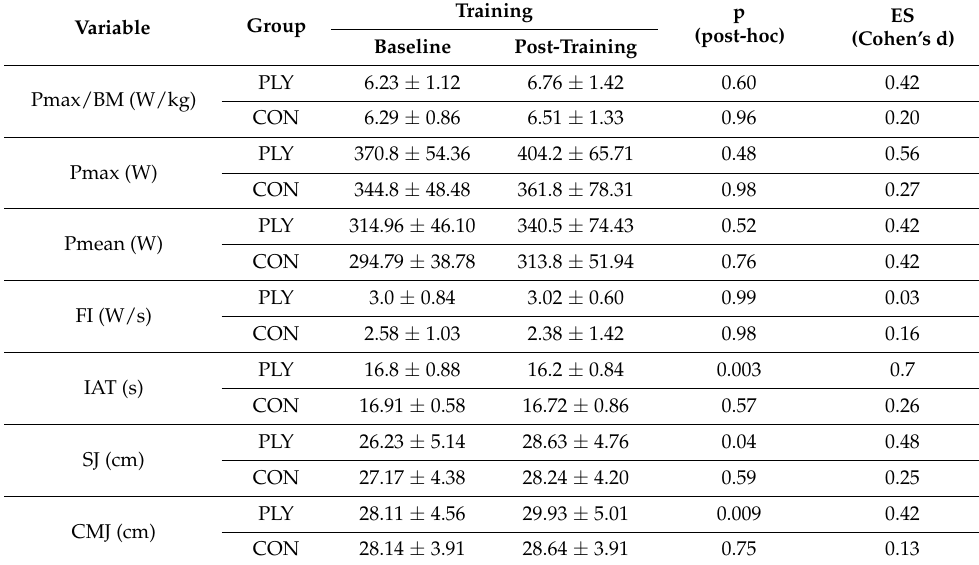
Table 2. Effects of plyometric training on agility, jump, and anaerobic performance in female soccer players.